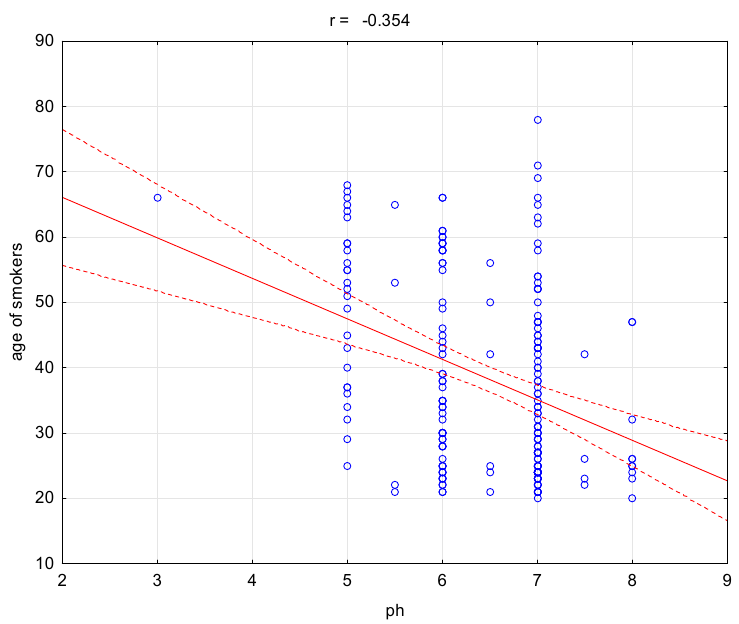
Figure 2. Correlation between age and pH for the smokers group (r = − 0.354, p ≤ 0.000).